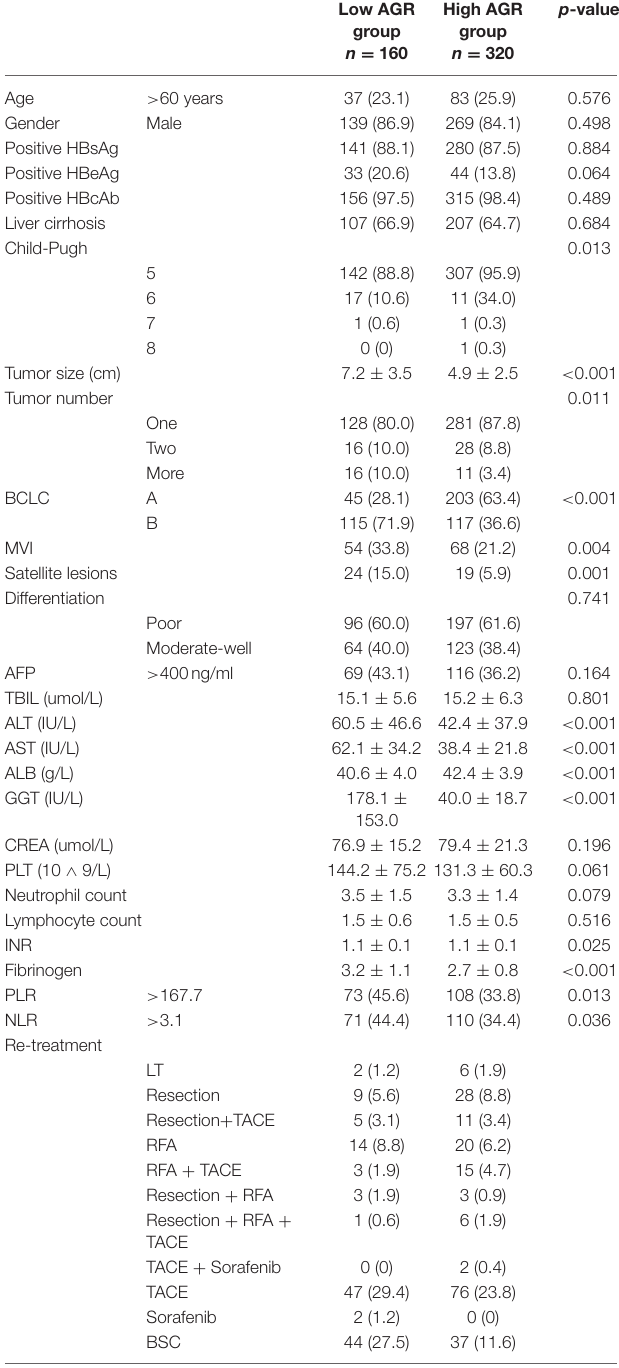
TABLE 1 | Patient clinical characteristics between low and high AGR group in training